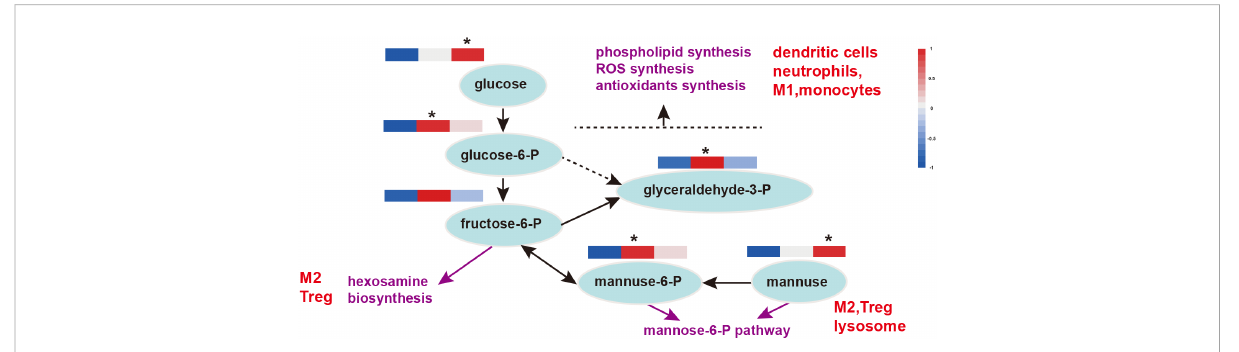
FIGURE 6 Glycolysis and the mannose-6-P pathway in immune function. Heat maps show the relative amounts of substances in group Con, TR1 and TR2 from left to right; * represent p <0.05, indicative of the signi fi cant difference by comparing TR1 or TR2 to Con; M1, type 1 macrophages; M2, type 2 macrophages; Treg, regulatory T cells; P,